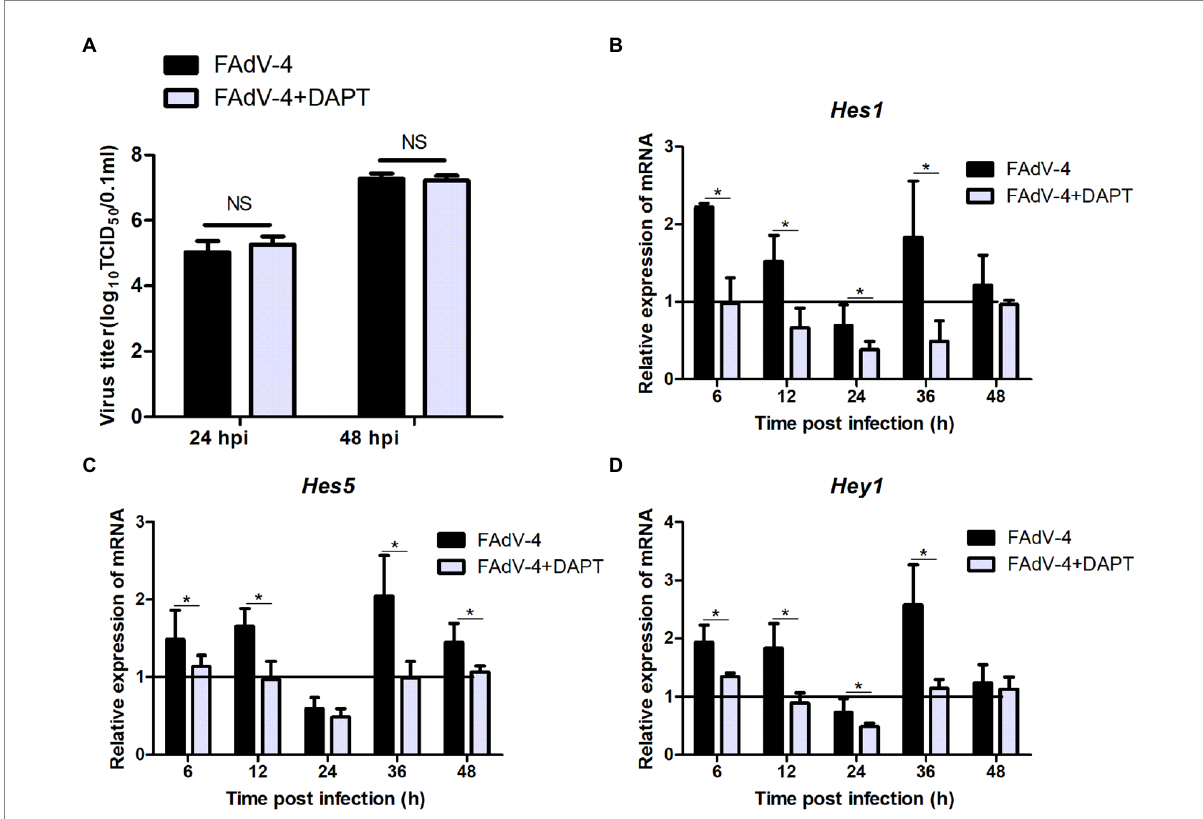
FIGURE 6 Effect of Notch signaling on viral replication during FAdV-4 infection in LMH. (A) Supernatants were harvested and tittered by TCID 50 assay at 24 and 48 hpi. (B–D) Cells were harvested, and then the expression of the target gene hes1 , hes5 , and hey1 were evaluated by qPCR. The y axis represents the fold change in target gene expression in FAdV-4 group and FAdV-4+ DAPT group compared with that of the control and the above line ( y = 1) on the x -axis represents the control. Data are shown as mean (SD) with n = 3 per group. NS, not statistically significant; * p < 0.05, represents the comparison between group FAdV-4 and group FAdV-4+